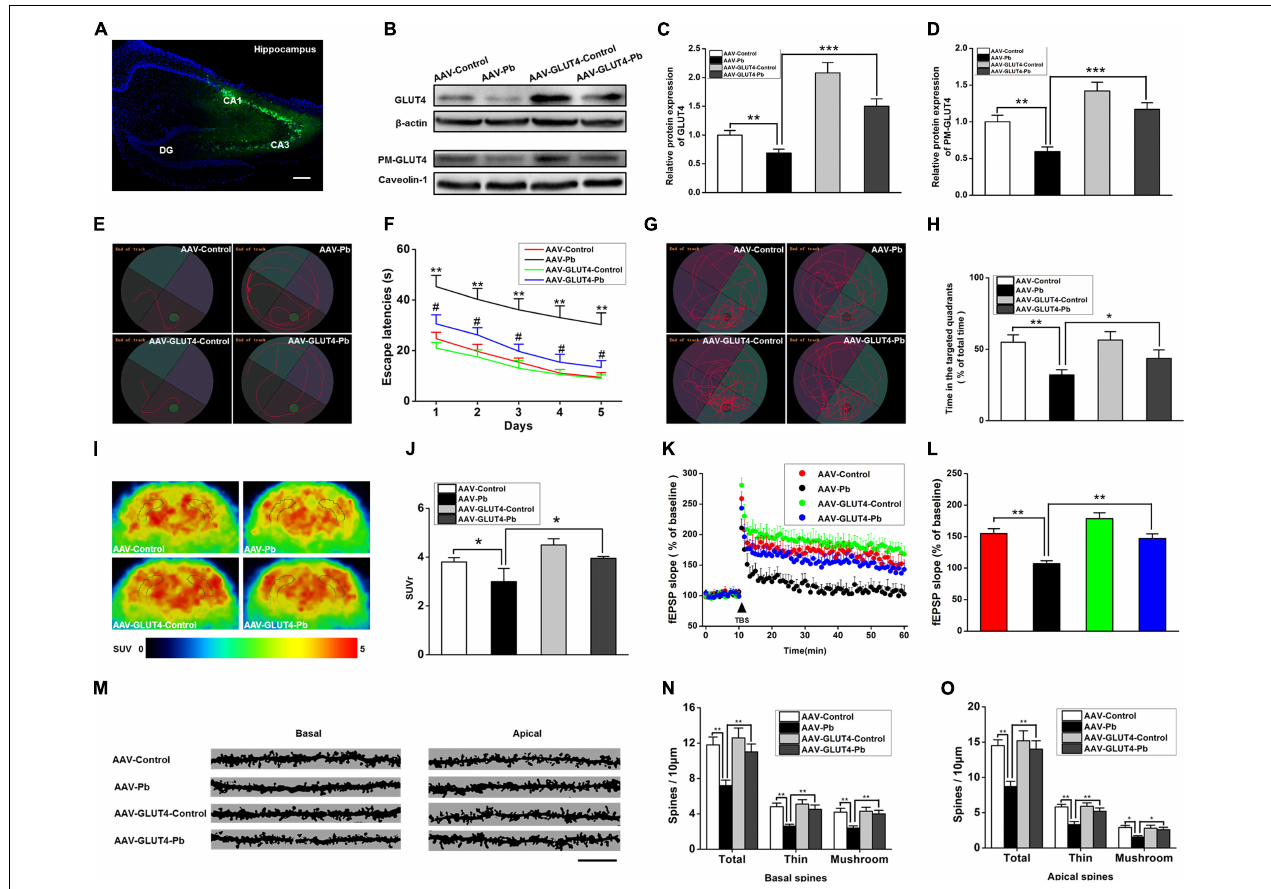
FIGURE 7 | Effects of GLUT4 over-expression in Pb-exposed rat hippocampus on the glucose uptake, synaptic plasticity, as well as learning and memory function. (A–D) Over-expression of GLUT4 in rat hippocampus and analysis of its effect on glycometabolism-related proteins. GLUT4 over-expression was induced via stereotactic injection of adenovirus. GLUT4 over-expression reversed the decreased PM-GLUT4 in Pb-exposed rat hippocampus. (E–H) Analysis of rat positioning, navigation ability, and space exploration trajectory. Over-expression of GLUT4 in Pb-exposed rat hippocampus reversed the arrival latency and the target quadrant retention time of model rats in MWM tests; * p < 0.05, ** p < 0.01; # p < 0.05 vs. AAV-Pb. (I,J) PET-CT scanning and analysis of glucose metabolism in rat brain. The glucose metabolism level in Pb-exposed rat hippocampus was reversed after the over-expression of GLUT4. (K,L) Effects of Pb exposure on LTP induction in rat hippocampus. After over-expression of GLUT4 in rat hippocampus, the slope of fEPSP in Pb-exposed rat hippocampus was reversed. (M–O) Effect of Pb exposure on dendritic spines of hippocampal pyramidal neurons. Over-expression of GLUT4 increased the spinal density of basal and apical dendrites in pyramidal neurons as well as the number of thin and mushroom-shaped dendritic spines in the Pb-exposed rat hippocampus. Scale bar = 10 µ m. * p < 0.05, ** p < 0.01, *** p < 0.001, vs. control, n = 6 per